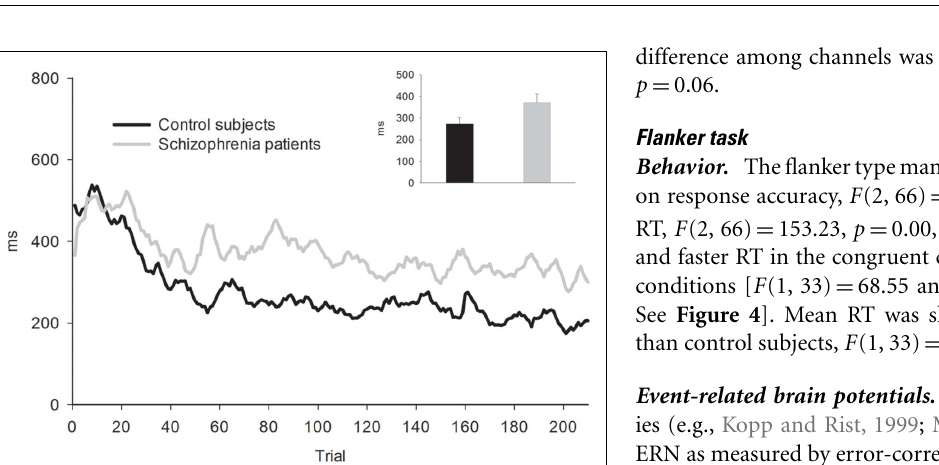
FIGURE 1 | Group averages for feedback ERN elicited by second stimulus in the passive gambling task. Data shown in waveforms are from Cz.The scoring window for the difference waves is indicated by the rectangle.